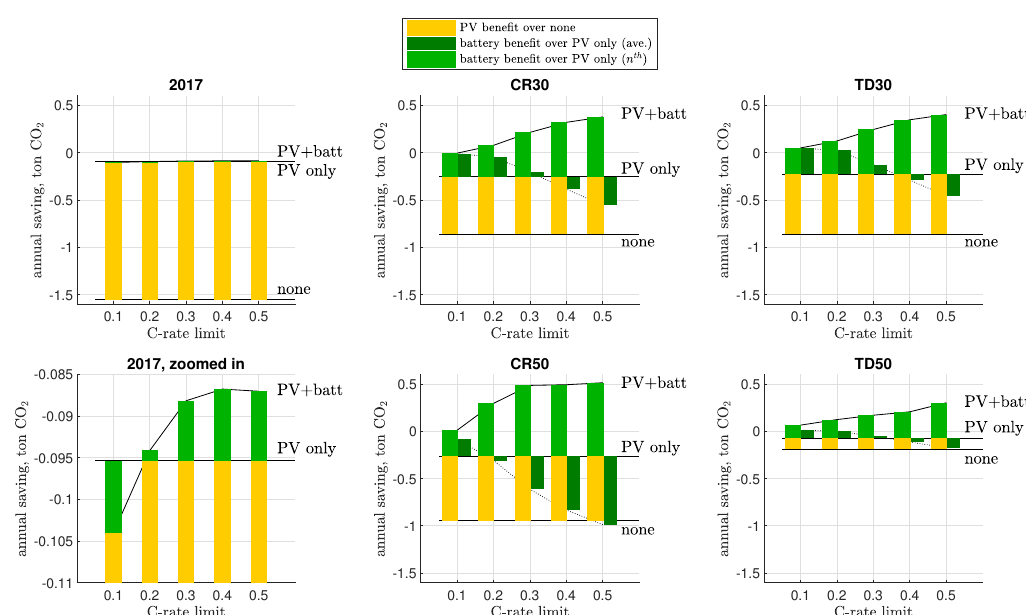
Figure 6. Annual CO 2 saving (tons) for varying C-rate limit, in 2017 and future scenarios, for average and n th systems. Savings are demarcated as benefit of PV only compared to no PV and no battery (‘none’), and benefit of PV and battery above PV only. Zero CO 2 saved denotes carbon-neutrality for the